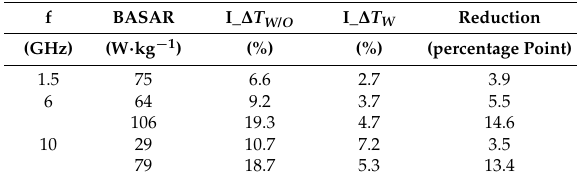
Table 3. Comparison between experimental and computed data based on Equation (9).